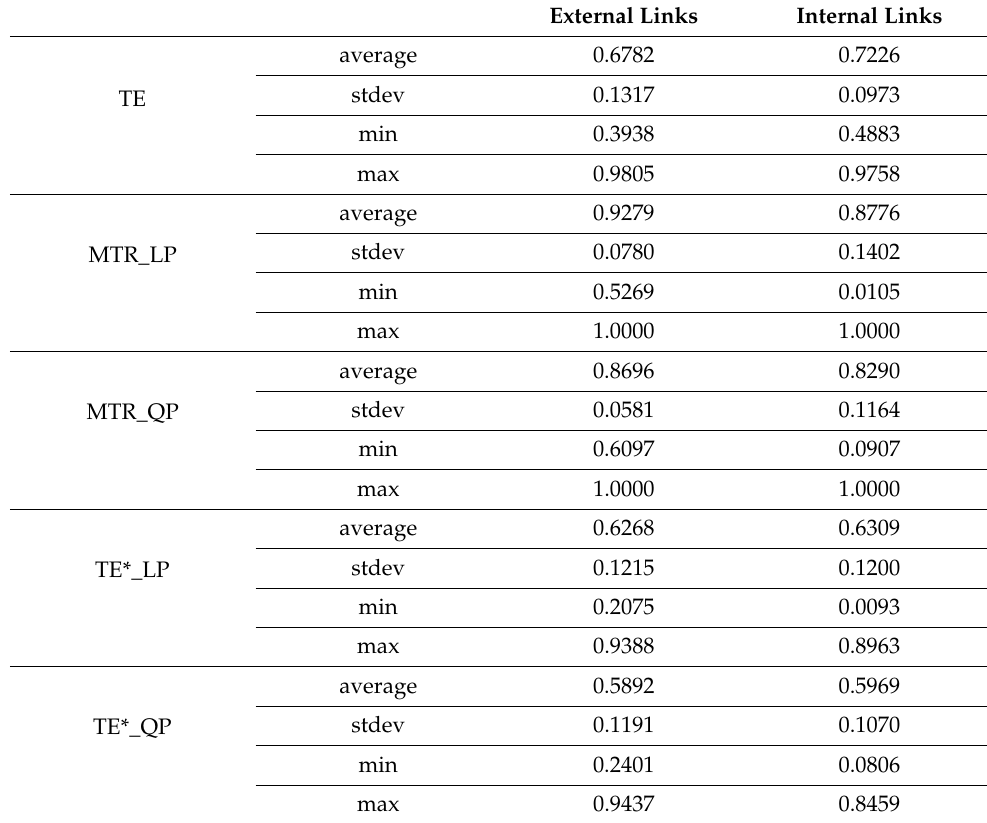
Table 3. SFA estimates of technical efficiencies and meta-technology